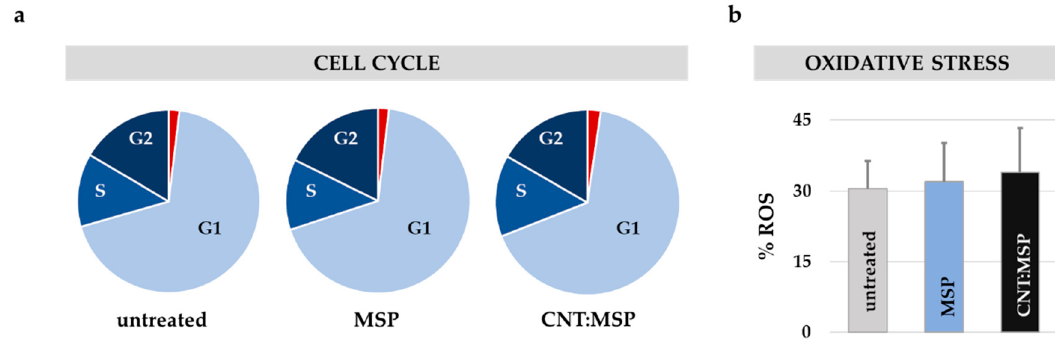
Figure 6. Silica dissolution is innocuous to HeLa cells. ( a ) HeLa cell cycle and viability 72 h after exposure to MSP or CNT:MSP. Cell cycle stages (in blue shades, G1 = non-dividing; S = duplicating phase; G2 premitotic / mitotic phase); and apoptotic cell (red) percentages in cultures of untreated (control) cells or cultures exposed to MSP or CNT:MSP. ( b ) Analysis of the oxidative stress in the cultures. In HeLa cells, no statistically-significant rise in the % of ROS was observed upon administration of MSP or CNT:MSP compared to untreated controls. The positive control (corresponding to 100% of ROS) was done adding 100 µ M of H 2 O 2 .